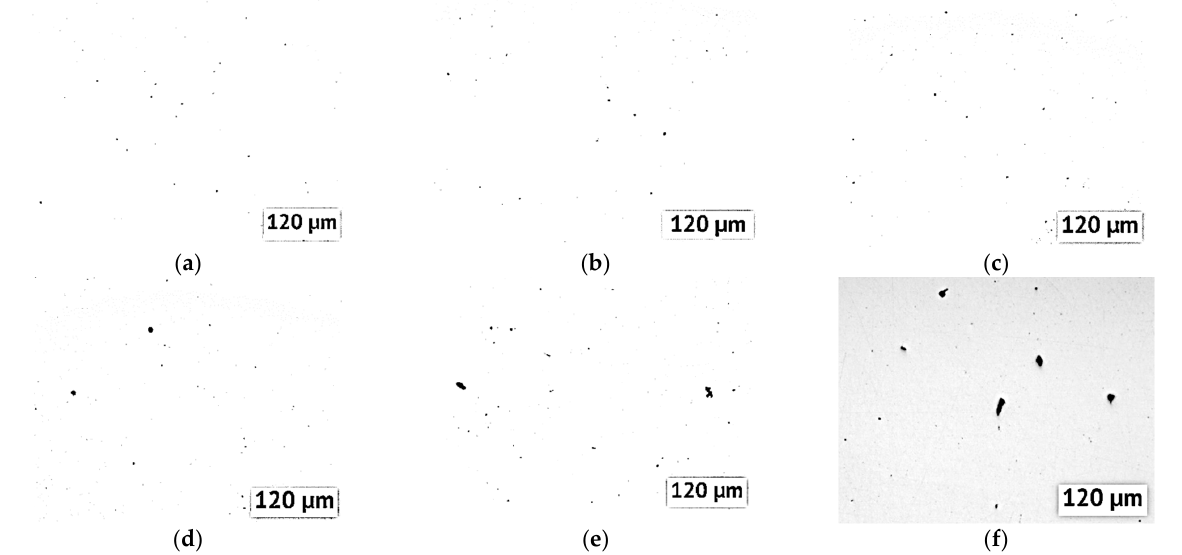
Figure 2. Porosity of the samples without Y ( a ), with 0.1%Y ( b ), with 0.2%Y ( c ), with 0.5%Y ( d ), with 1%Y ( e ), with 2%Y ( f ) after single laser scan. Pores are marked in black.